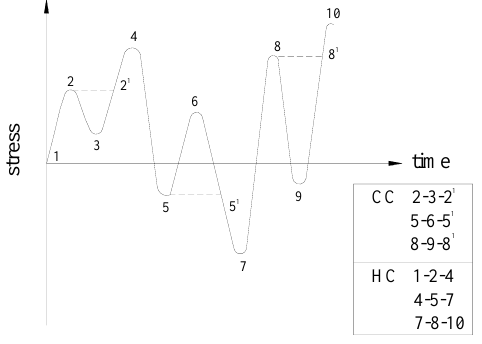
Fig.7. Stress-time history (CC-Complete Cycles, HC-Half